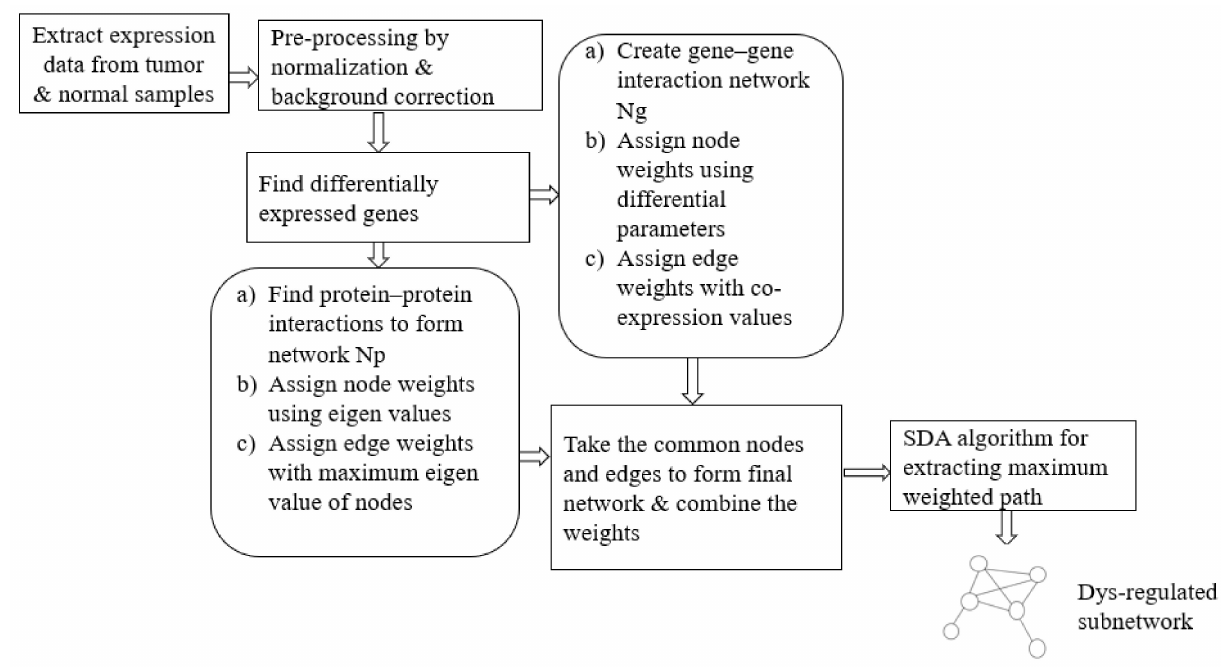
Figure 1. Data Flow of the proposed approach for subnetwork detection. The Smell Detection Agent (SDA) optimisation algorithm is applied on the network created using gene interaction data and protein–protein interaction